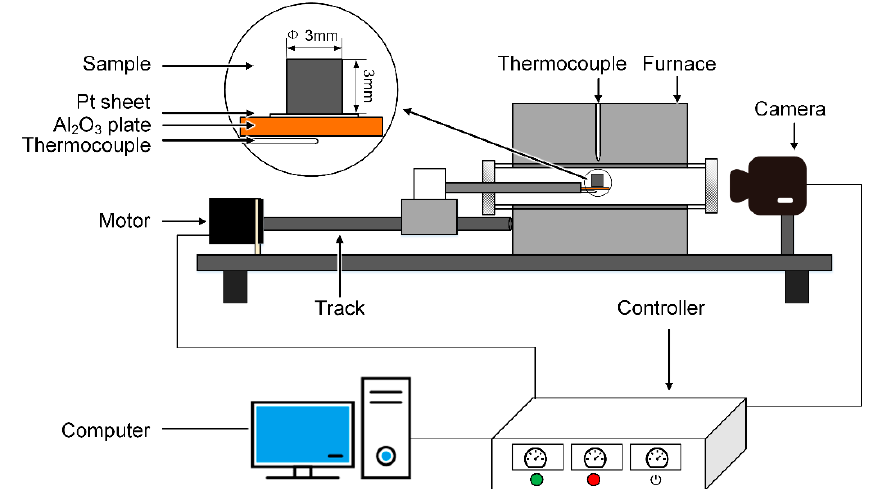
Figure 2. Illustration of RDS-05 measuring device for the slag melting point.